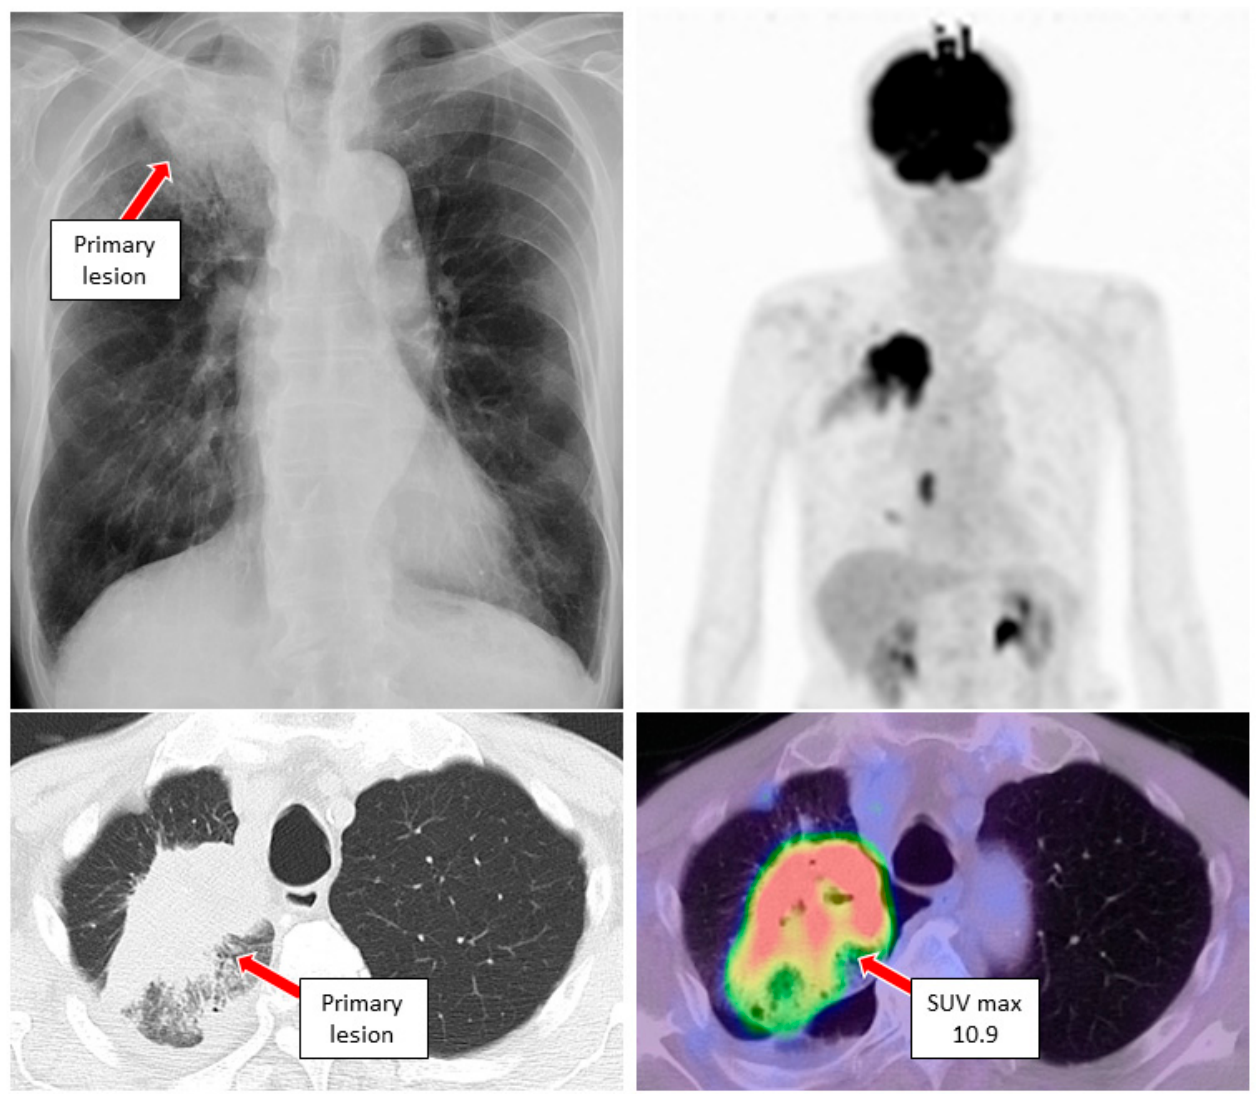
Figure 5. Chest X-ray, CT and FDG-PET examinations in case 2 revealed primary lung cancer at the right upper lobe. CT: computed tomography, FDG-PET: 18F-2-fluoro-2-deoxy-D-glucose-positron emission tomography.